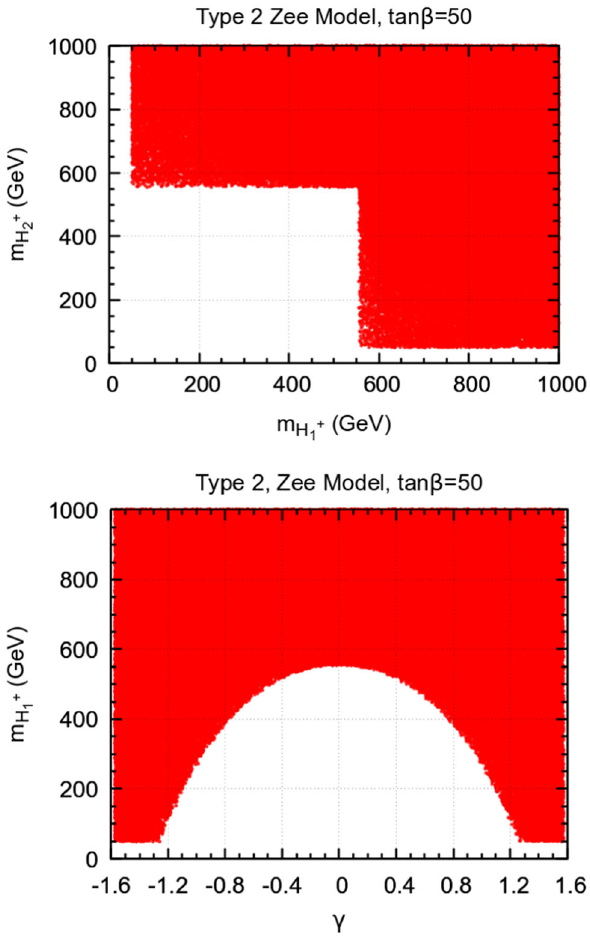
Fig. 2 Upper panel: points satisfying Eq. (63) for Zee-type models. Lower panel: mass of the lightest charged scalar boson as a function of the mixing angle